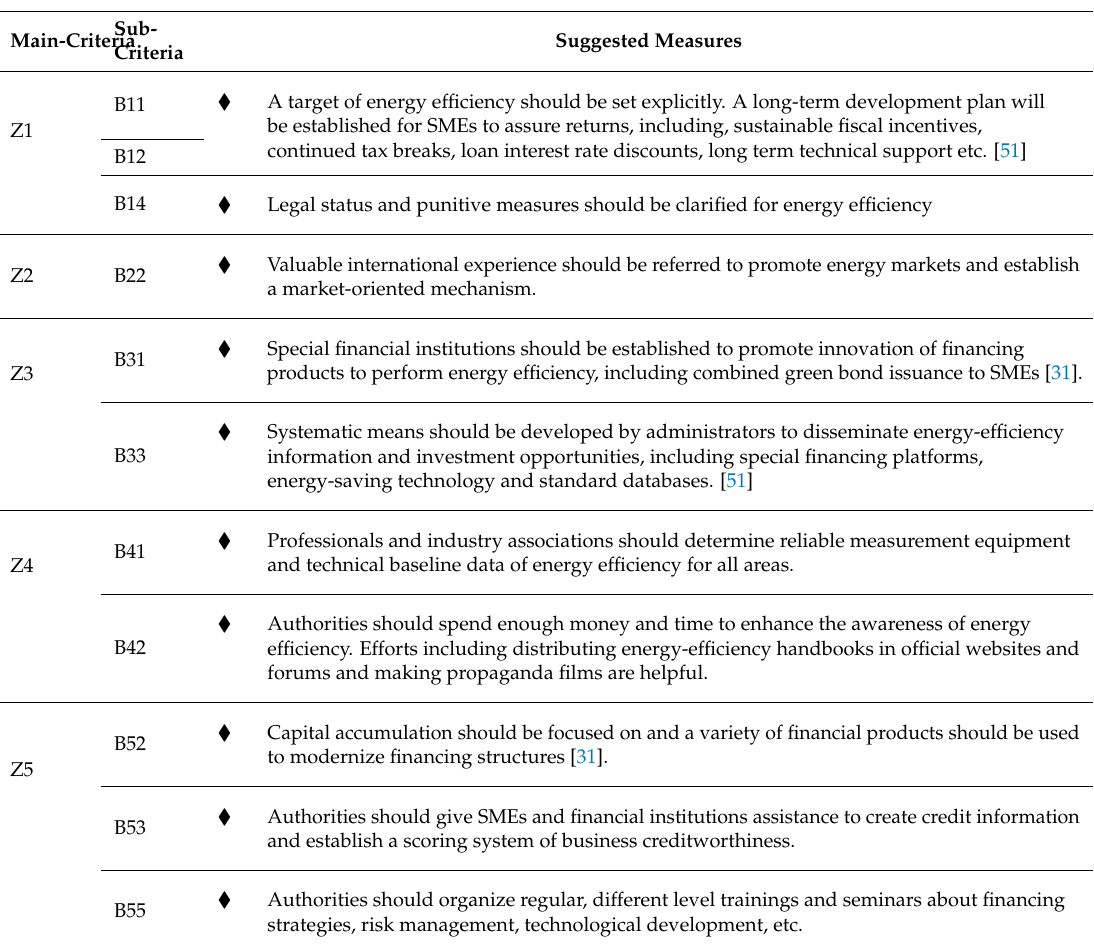
Table 15. Suggested measures to overcome key